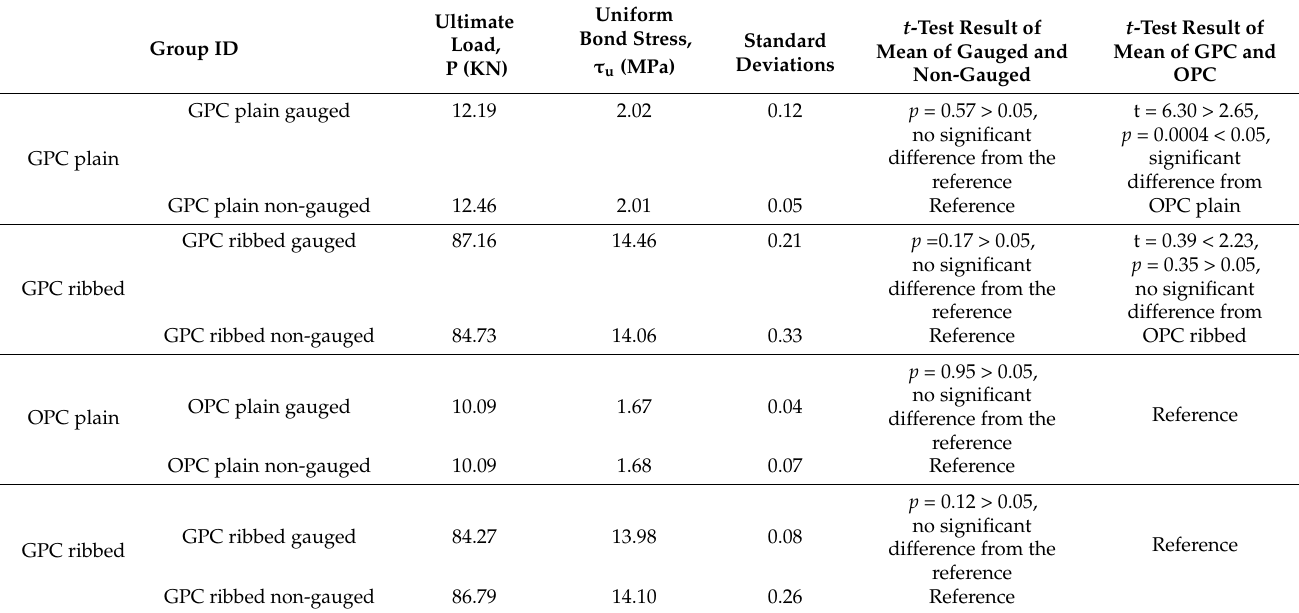
Table 4. Bond strength of OPC and GPC